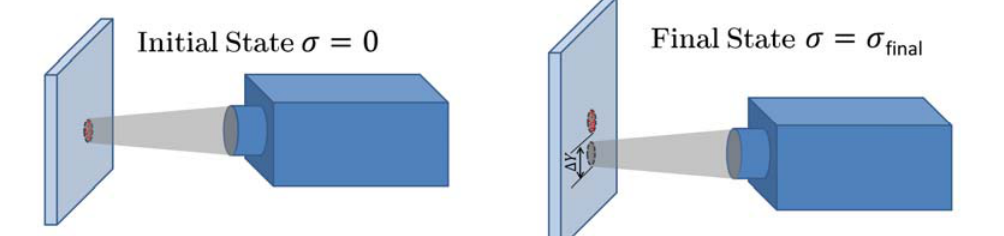
Figure 3: Using a high magnification can displace the target zone outside the microscope observation